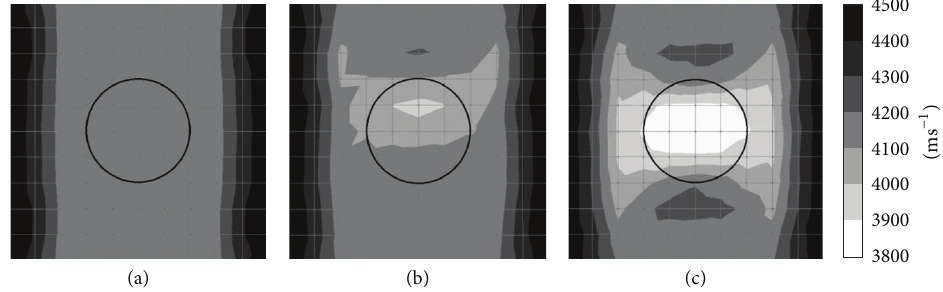
Figure 4: Tomograms of model with a total number of 12 sensors attached to left and right sides: (a) 0% void; (b) 50% void; (c) 100%